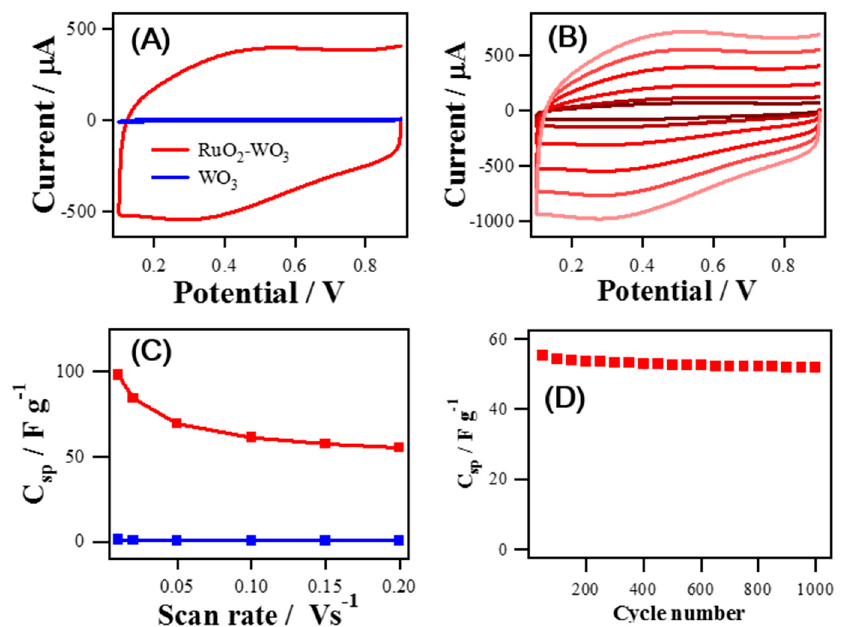
Figure 4. Capacitive current measurements in 1 M H 2 SO 4 solution for ( A ) RuO 2 NRs-WO 3 NFs and WO 3 NFs at a scan rate 100 mV s -1 , and ( B ) RuO 2 NRs-WO 3 NFs with varing the scan rate from 10 mV s -1 to 200 mV s -1 . ( C ) Changes of specific capacitance (C sp ) values of RuO 2 NRs-WO 3 NFs and WO 3 NFs as a function of the CV scan rate (from 10 mV s -1 to 200 mV s -1 ). ( D ) Plot of the C sp values of RuO 2 NRs-WO 3 NFs depending on the number of repeated CV cycles in 1 M H 2 SO 4 .